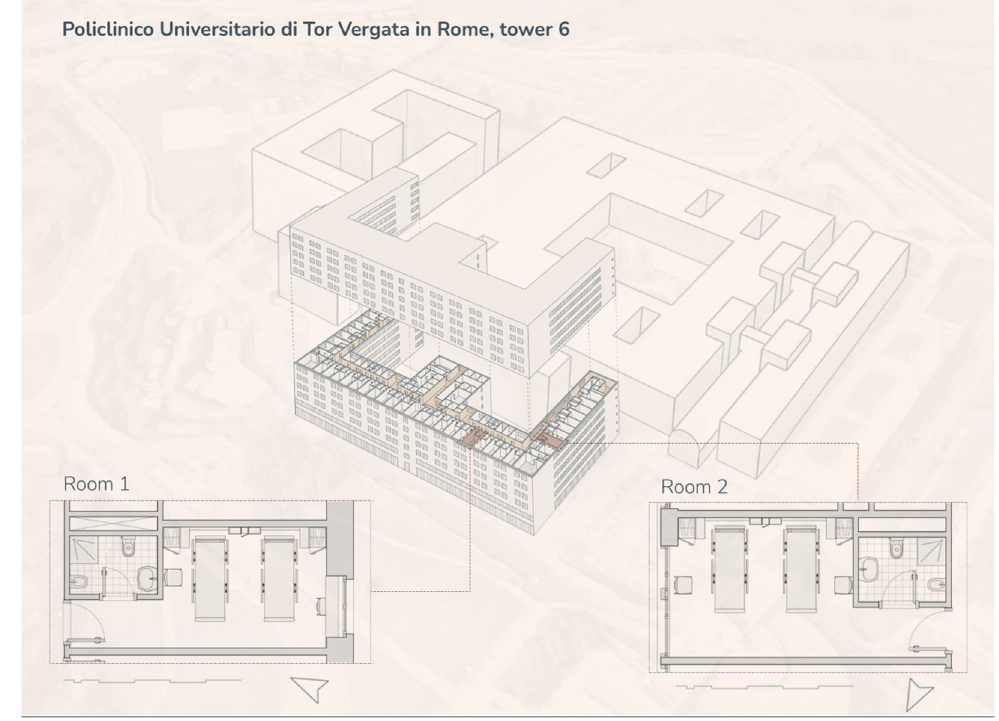
Figure 7. Location of the two in-patient rooms in the case-study building.